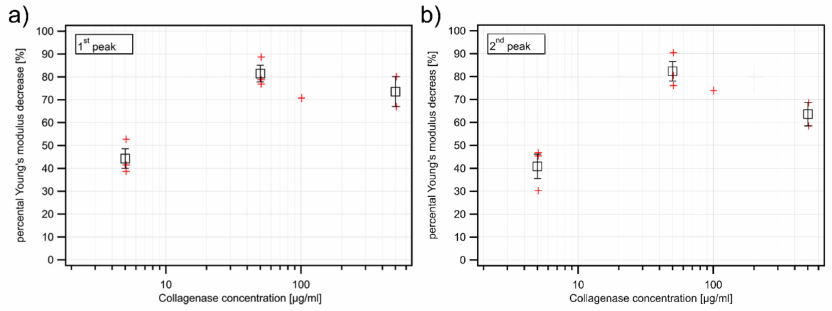
Figure 5. ( a ) Percentage decrease of Young’s modulus at di ff erent collagenase concentrations in µ g / mL determined with IT-AFM and the means of the results of the 1st peak and ( b ) of the 2nd peak. The red crosses indicate individual measurements and the black squares are the corresponding mean values with error bars indicating the standard error of the means. At the concentration of 100 µ g / mL, only one data set (FGB and IT-AFM) is available, therefore no mean value and standard error were calculated for this concentration. The p -values of one-way unbalanced ANOVA tests against native sample variation for 5, 50, and 500 µ g / mL are 0.005, 0.0002, and 0.0033 for the first peak (a) and 0.0111, 0.0003, and 0.004 for the second peak